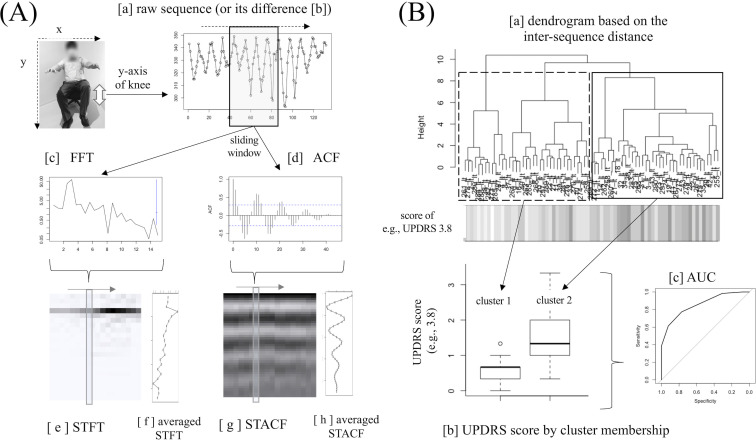
Processing workflow.